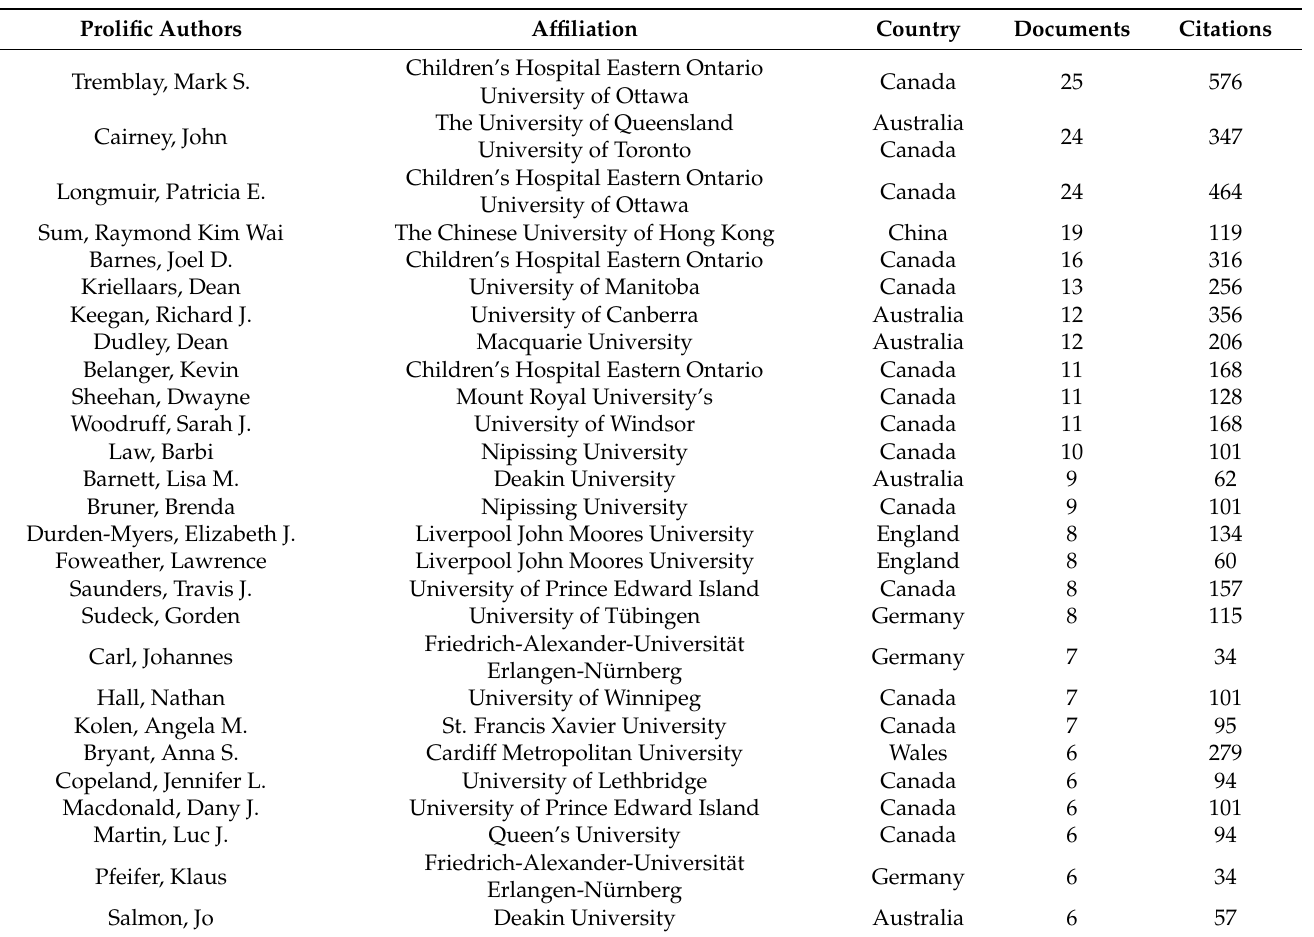
Table 3. Prolific authors with affiliation, country, total number of documents, and total number of